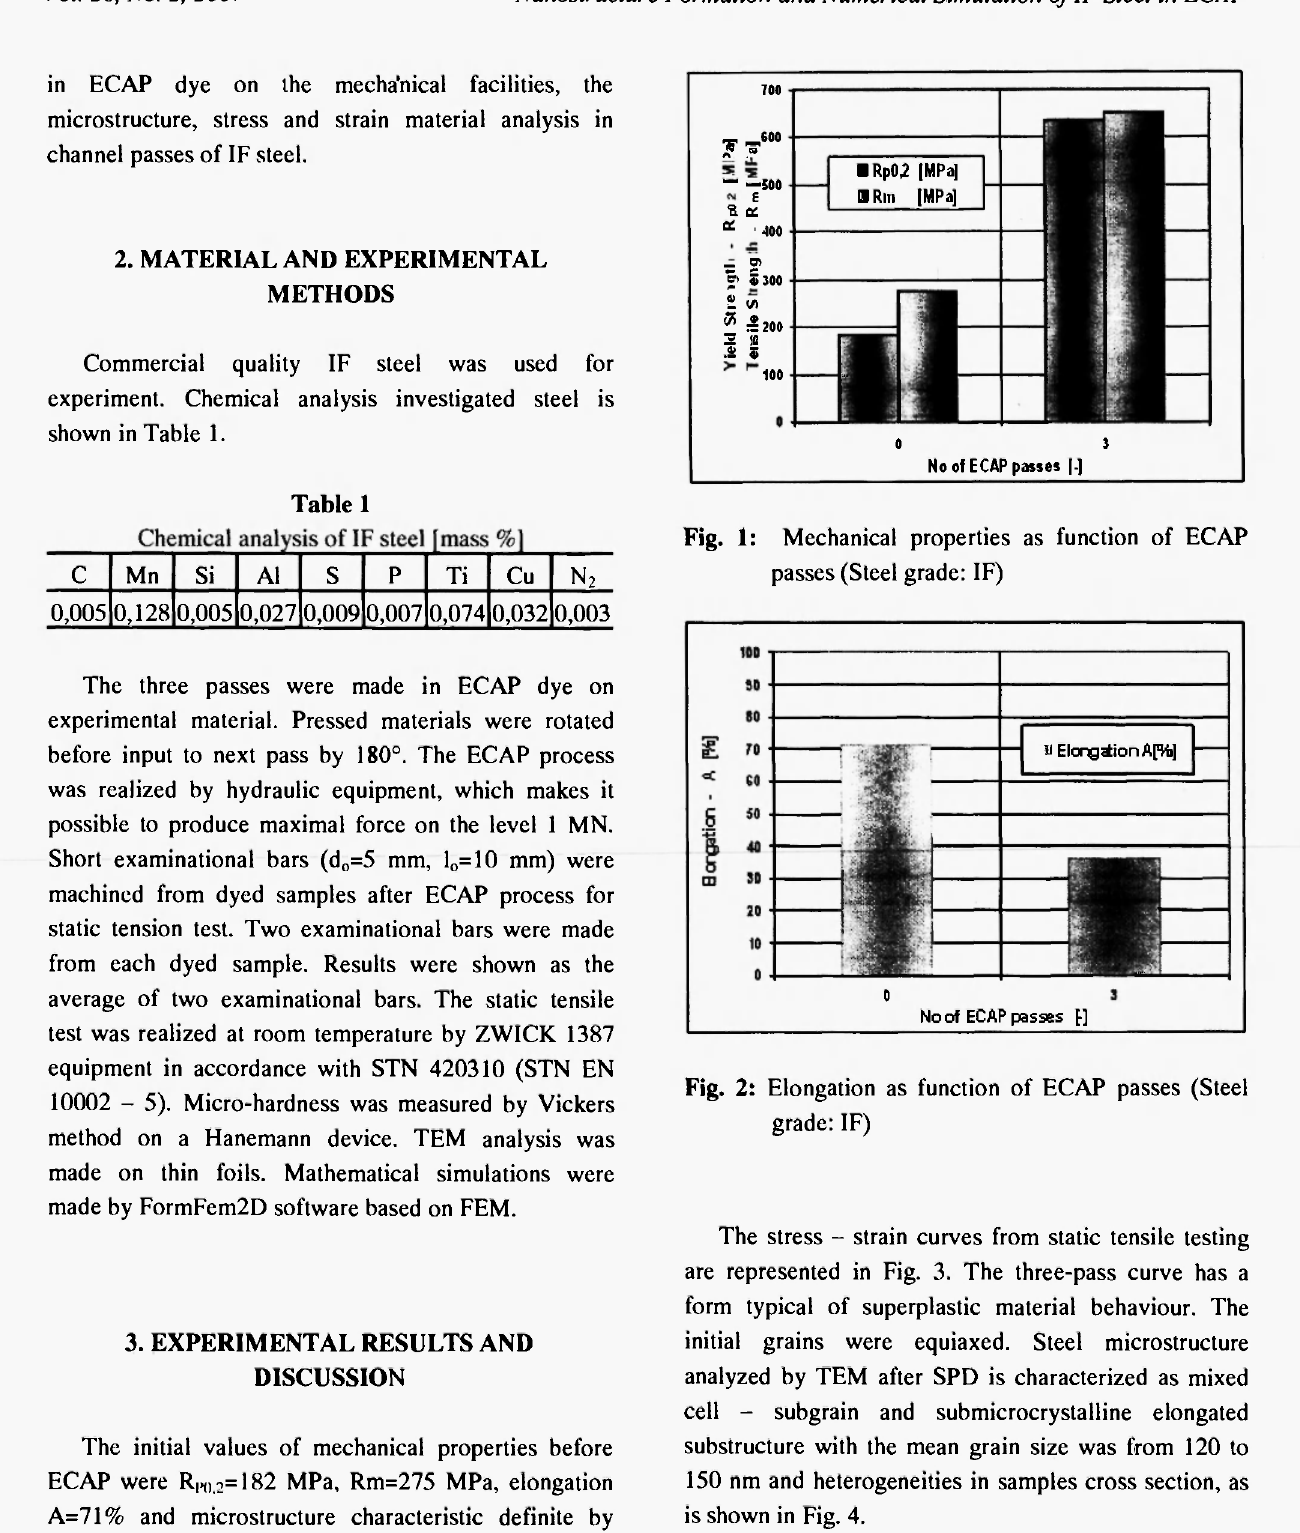
The stress - strain curves from static tensile testing are represented in Fig. 3. The three-pass curve has a form typical of superplastic material behaviour. The initial grains were equiaxed. Steel microstructure analyzed by TEM after SPD is characterized as mixed cell - subgrain and submicrocrystalline elongated substructure with the mean grain size was from 120 to 150 nm and heterogeneities in samples cross section, as is shown in Fig.